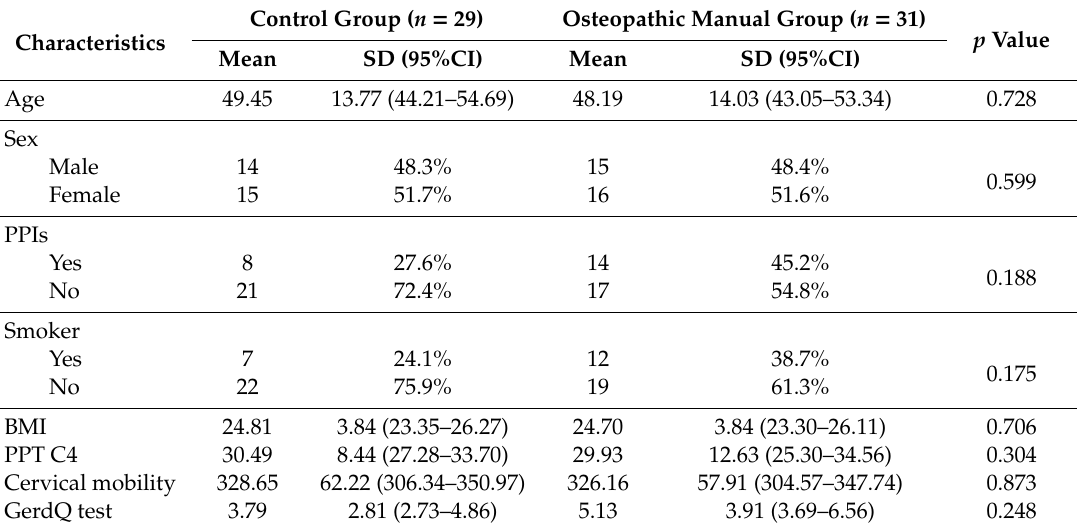
Figure 2. CONSORT Flow Diagram. Table 1. Baseline Characteristics of Participants.